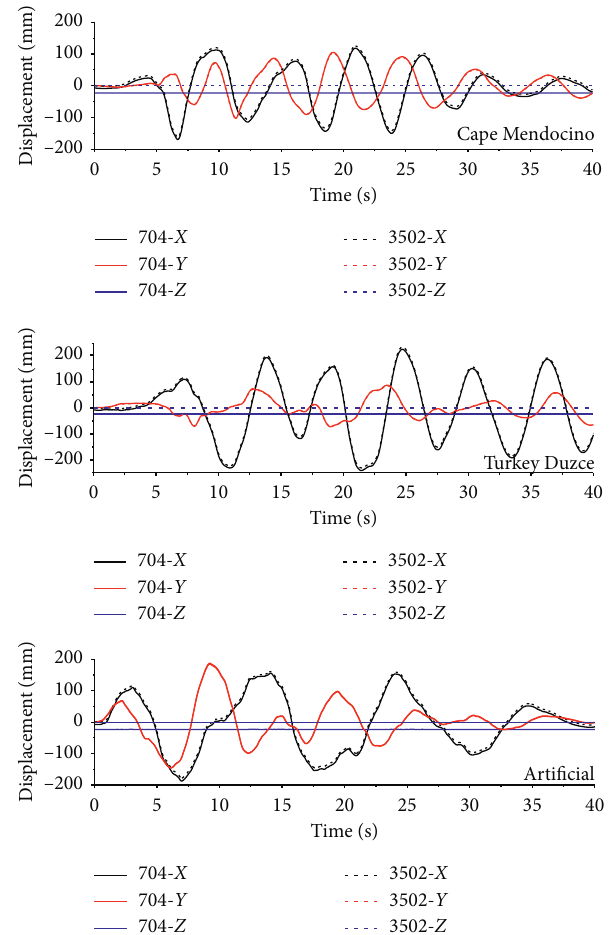
Figure 12: Displacement–time curves of climbing formwork with core tube under the construction